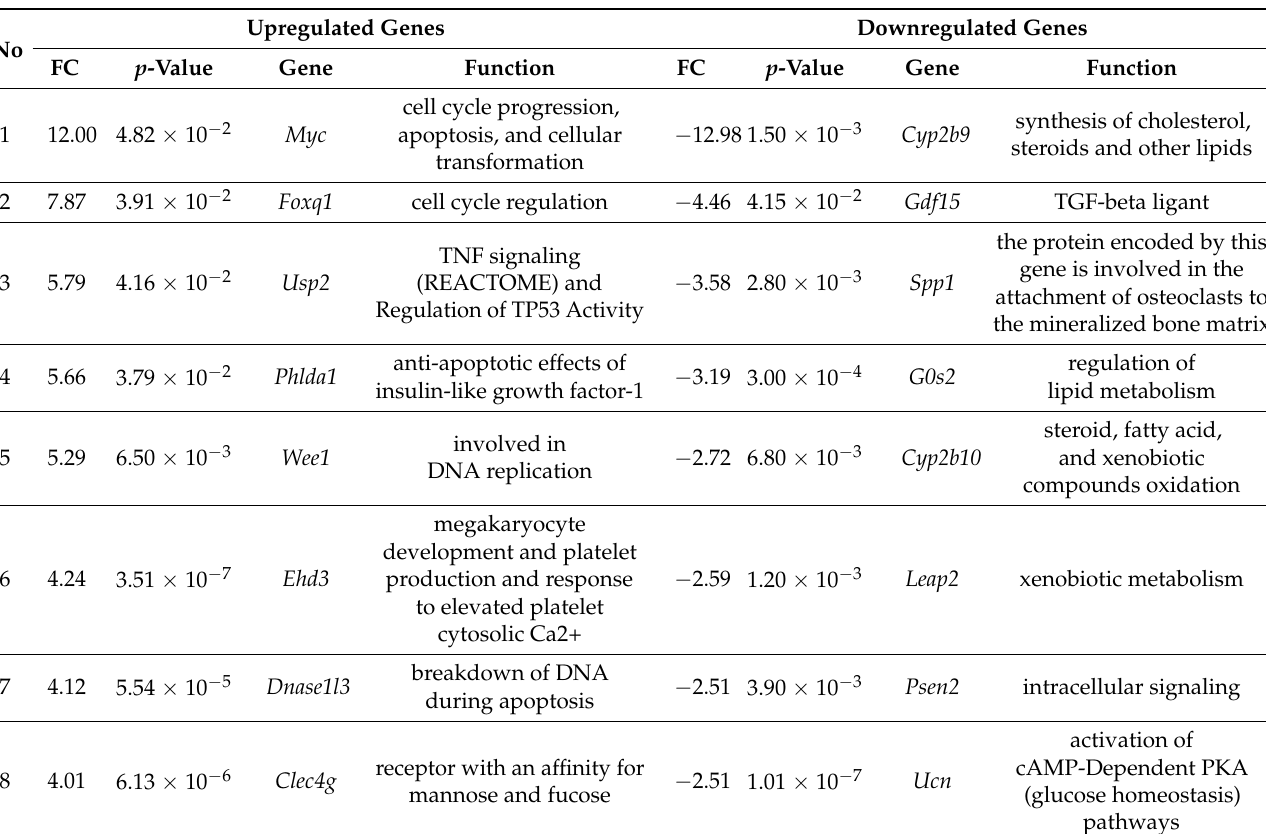
Table 2. Top 25 upregulated and downregulated genes of liver from male C57BL/6J mice fed HF+CP after 10 weeks. FC: Fold